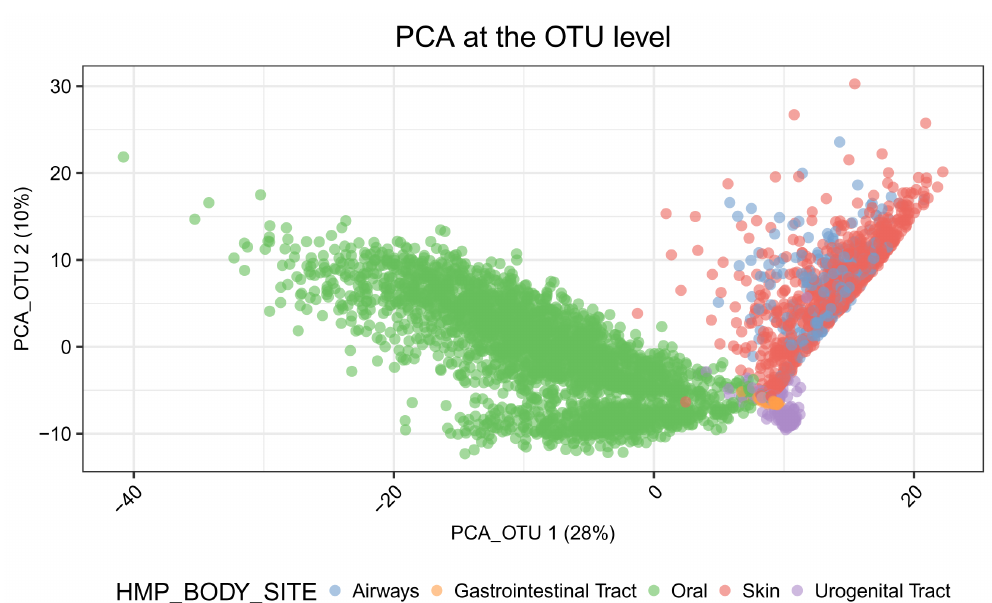
Figure 8. Principal component analysis (PCA) plot of samples using data at the OTU level. The first two principal components (PCs) are plotted. Each point represents a sample. Samples are coloured according to the body sites.